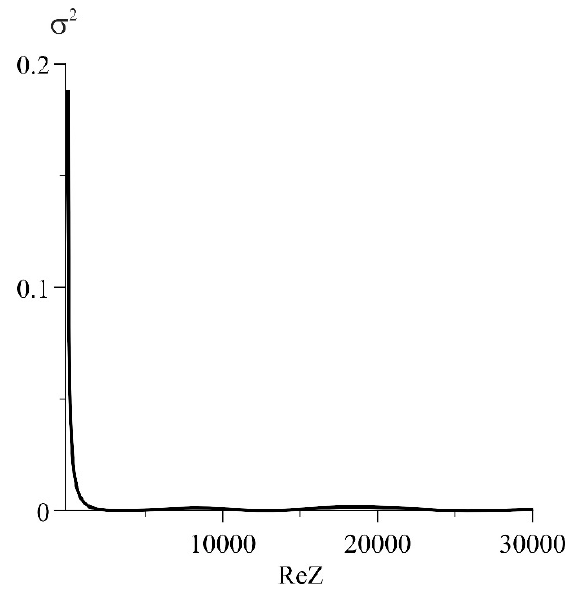
Figure 8. Dependence of the normalized squared deviations σ 2 on ReZ.